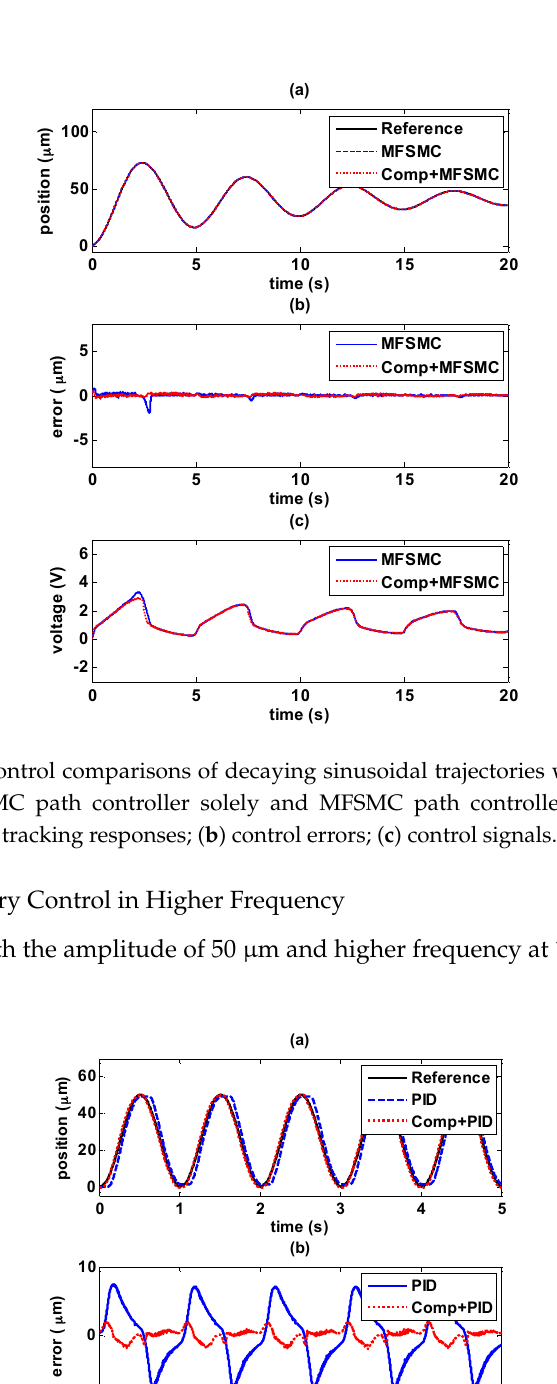
Figure 19. Tracking control comparisons of sinusoidal trajectory with 1 Hz frequency and 50 μ m amplitude between using PID path controller solely and PID path controller with the hysteresis compensator: ( a ) path tracking responses; ( b ) control errors; ( c ) control signals.